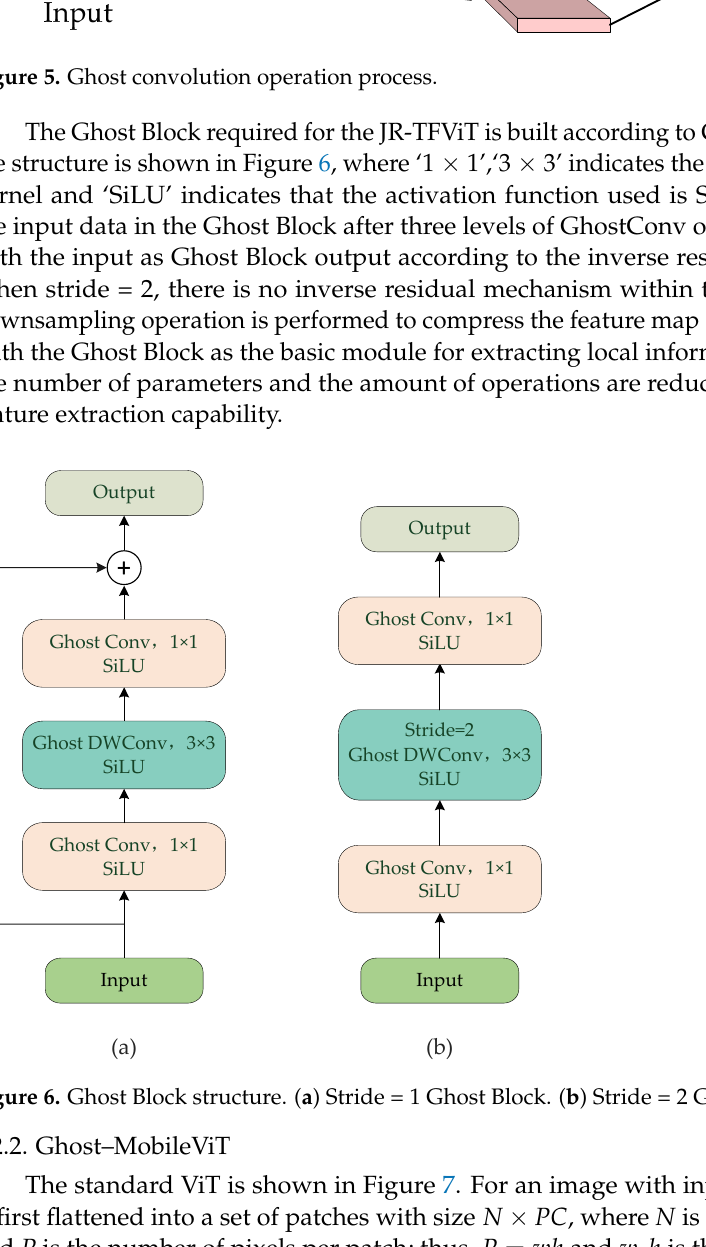
Figure 6. Ghost Block structure. ( a ) Stride = 1 Ghost Block. ( b ) Stride = 2 Ghost Blocks.